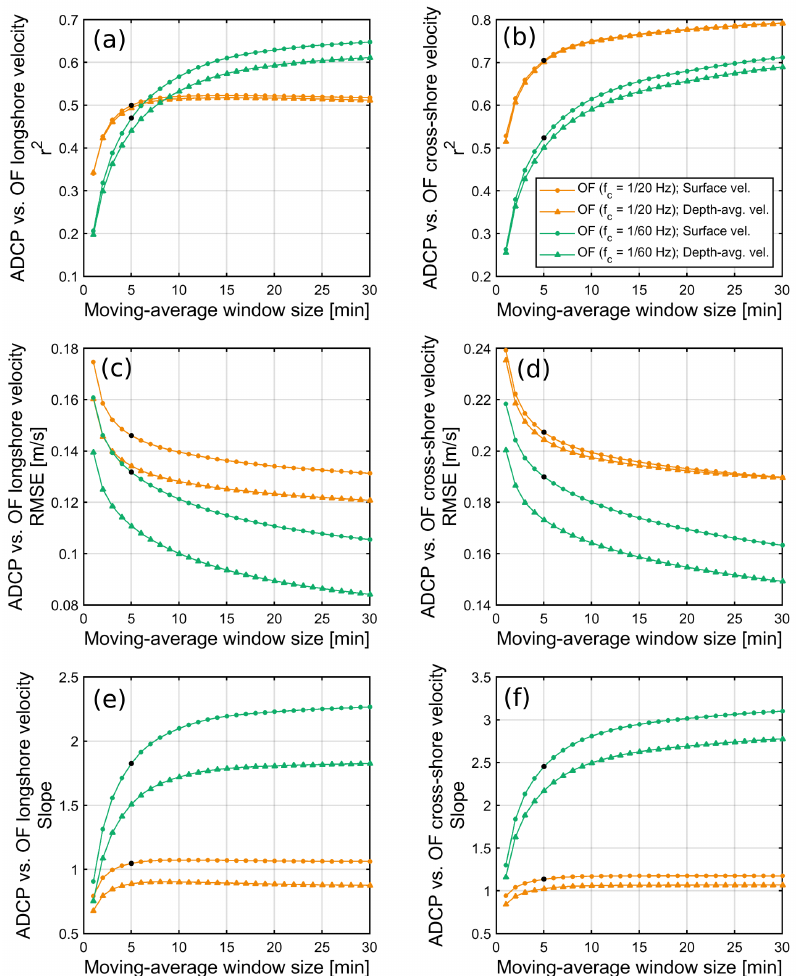
Figure 7. Statistical parameters showing the agreement between ADCP vs. optical flow velocity com- ponents by changing the temporal moving-average window size. Data set from 8 to 15 October 2018 using low-pass filtered images with f c = 1/20 Hz (orange line) and f c = 1/60 Hz (green line) for optical flow input. Optical flow velocities are compared against ADCP surface velocities (average between σ 19 , σ 20 and σ 21 ; line with circles) and depth-averaged velocity measurements (average of all σ -layers; line with triangles). ( a , b ) Coefficient of determination ( r 2 ), ( c , d ) root mean square error (RMSE) and ( e , f ) linear regression slope for longshore and cross-shore velocity components. The black dots correspond to the 5-min time-averaging window used in previous